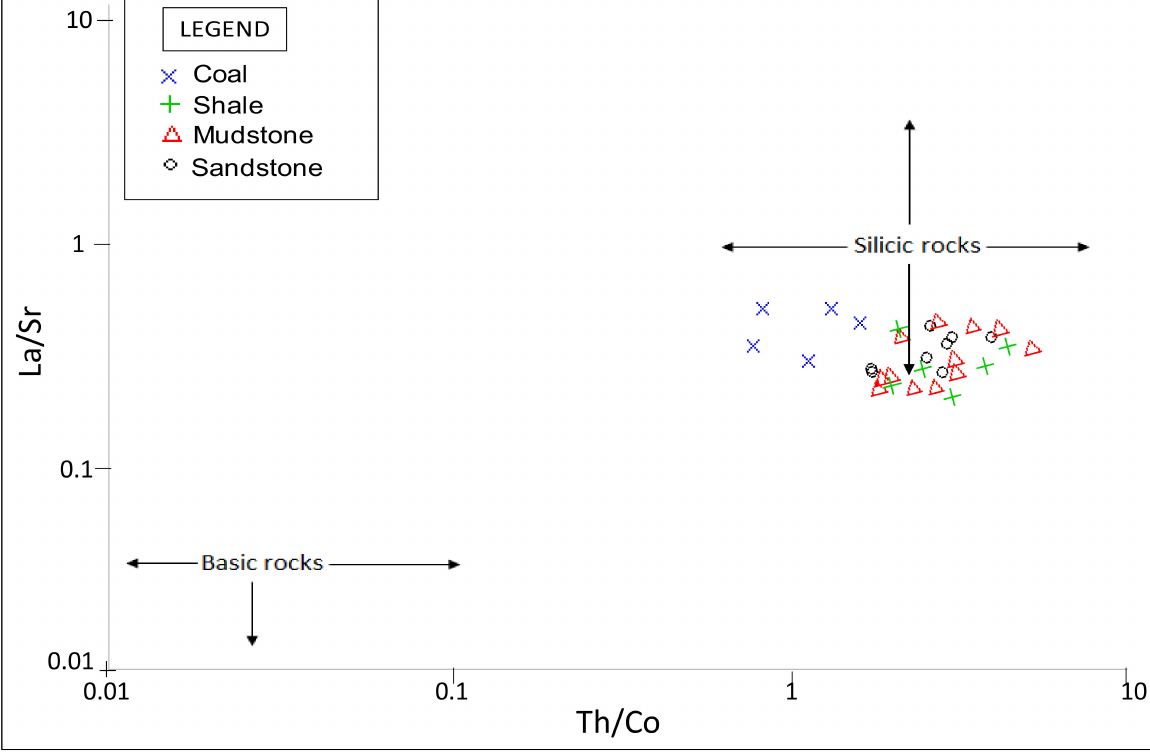
Figure 14. Binary plot of La/Sr versus Th/Co for the studied samples showing provenance (Background field after